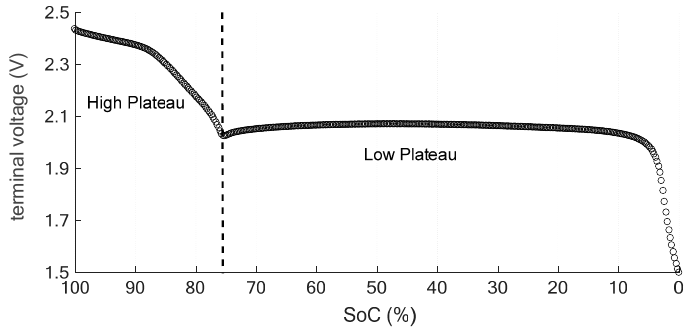
Figure 3. Li-S cell terminal voltage during slow discharge at C/30.